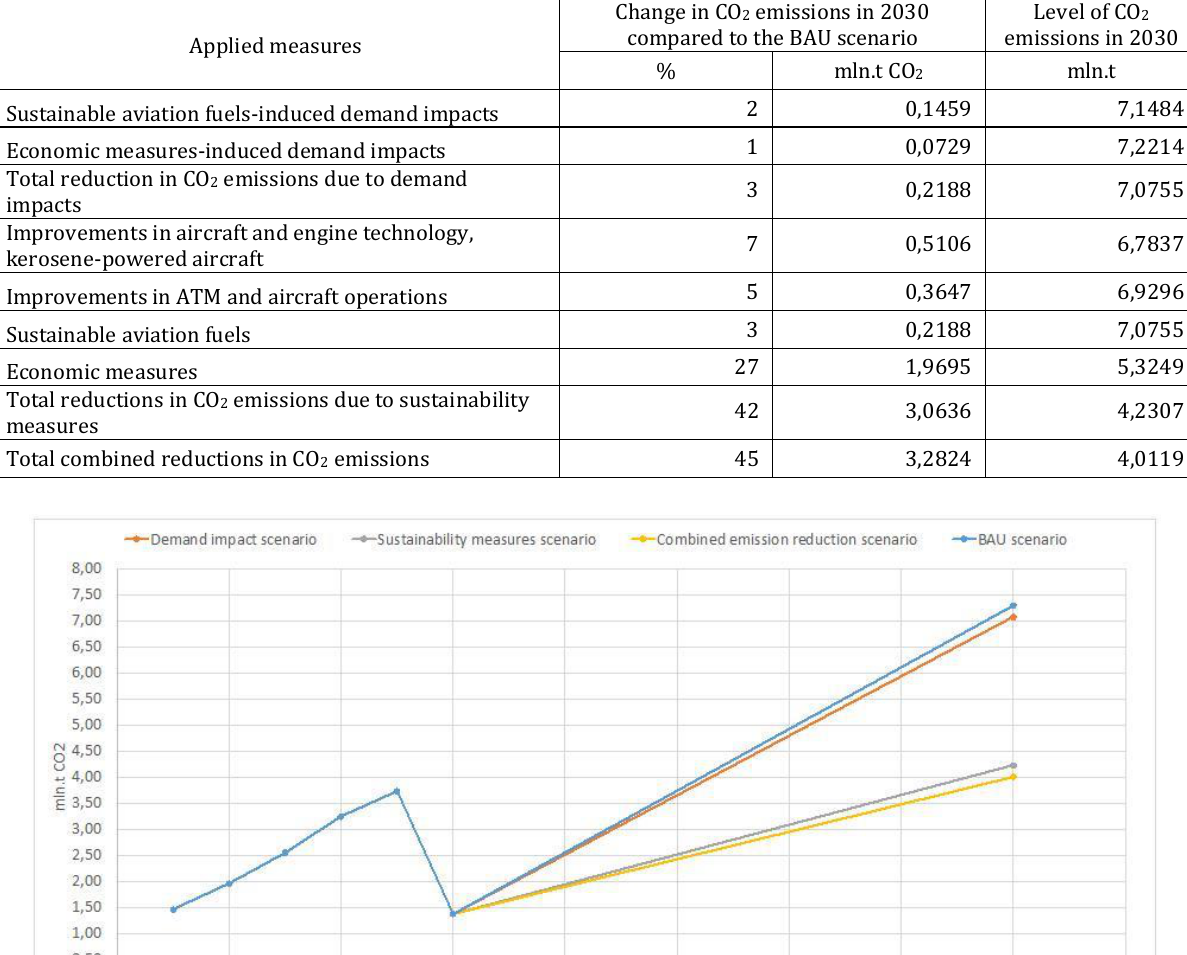
Table 5. Reductions in CO 2 emissions for Ukraine, up to 2030, compared to the BAU scenario Applied measures